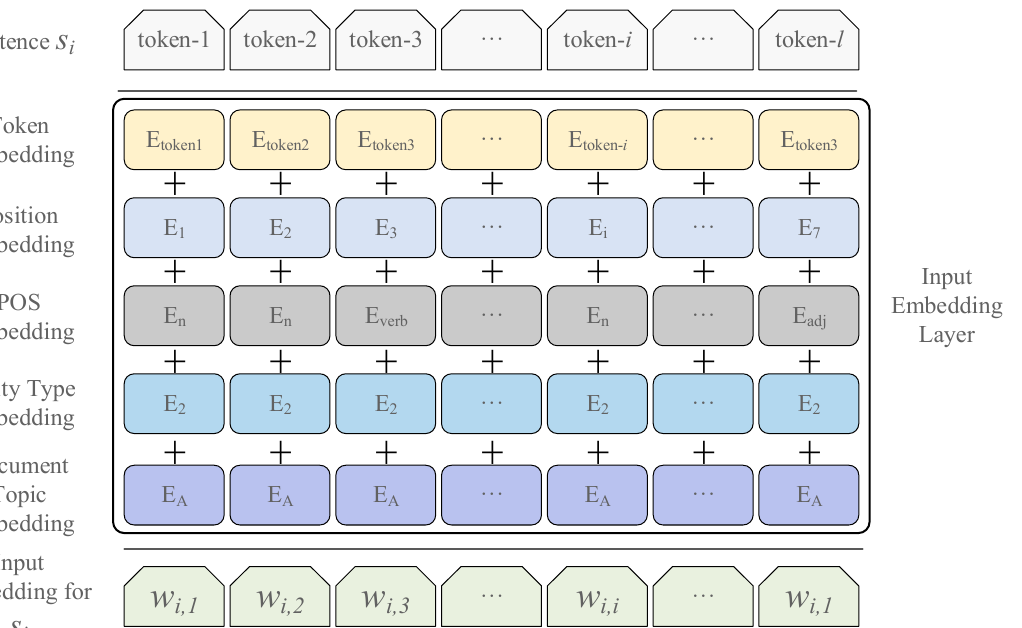
Figure 3. The input embedding layer of sentence-level encoder. The input embeddings for each token are the sum of the token, position, POS, entity type, and the document topic embeddings.